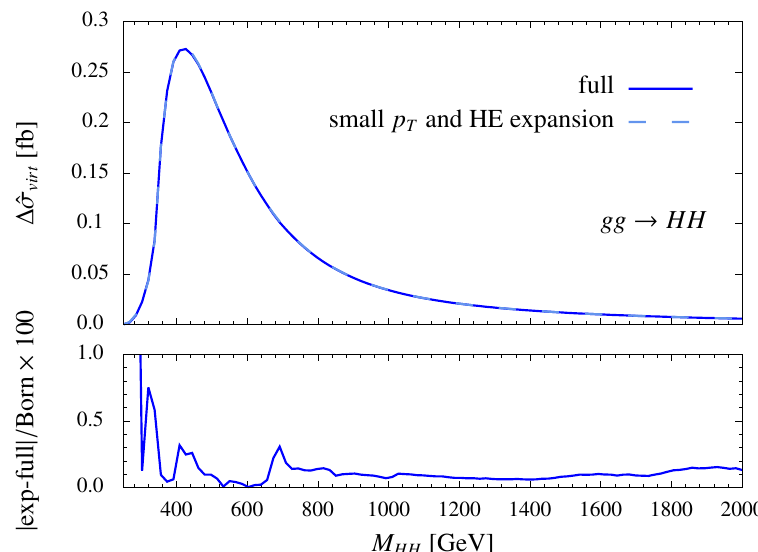
Figure 4. Upper panel: ∆ˆ σ virt using the numerical grid provided in ref. [29] (dark blue line) and our combination of HE expansion and small p expansion (light blue dashed line). The lower panel T shows the absolute value of the difference between the two results, normalized to the partonic LO cross section.